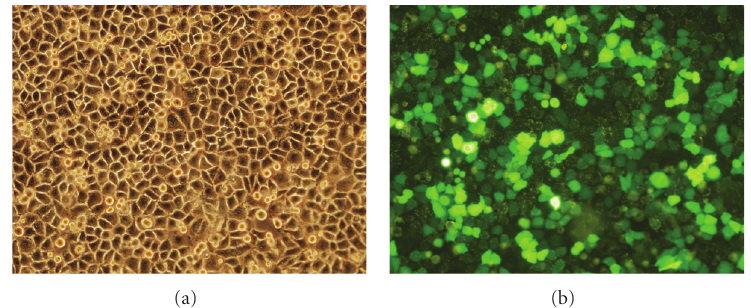
Figure 1: Transfection of HepG2 cells using Amaxa Nucleofector and monitored by transient transfection of pEGFP vector: (a) phase contrast image of cells 48 hours after transfection: (b) the corresponding image of the green fluorescent by pEGFP in the same field (Olympus IX71 fluorescent microcopy).